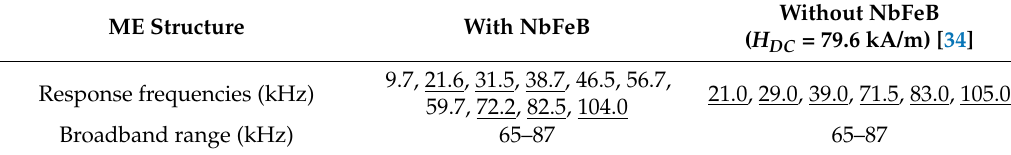
Figure 6. The frequency dependences of α E for ME structures with mica trestles. Table 2. The resonance frequencies in ME structures with mica trestles.